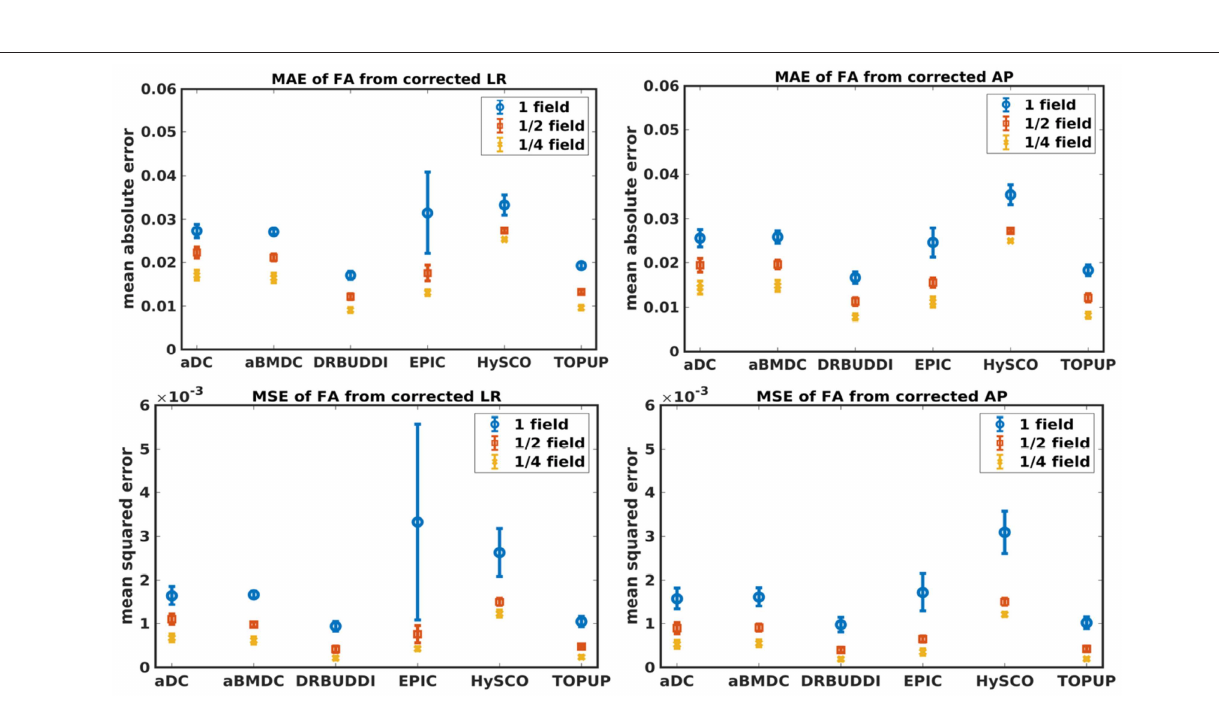
Frontiers in Neuroinformatics |